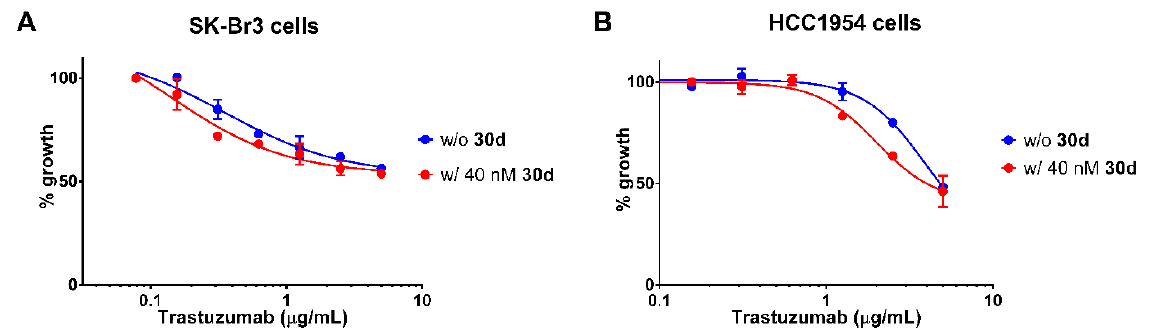
Figure 8. Synergism between 30d and trastuzumab in ( A ) SK-Br3 cells and ( B ) HCC1954 cells. Antiproliferative activity of trastuzumab was slightly enhanced in both cells by co-treatment of 40 nM of 30d . The blue line indicates the titration of trastuzumab only, and the red line indicates the titration of trastuzumab in the presence of 40 nM 30d .